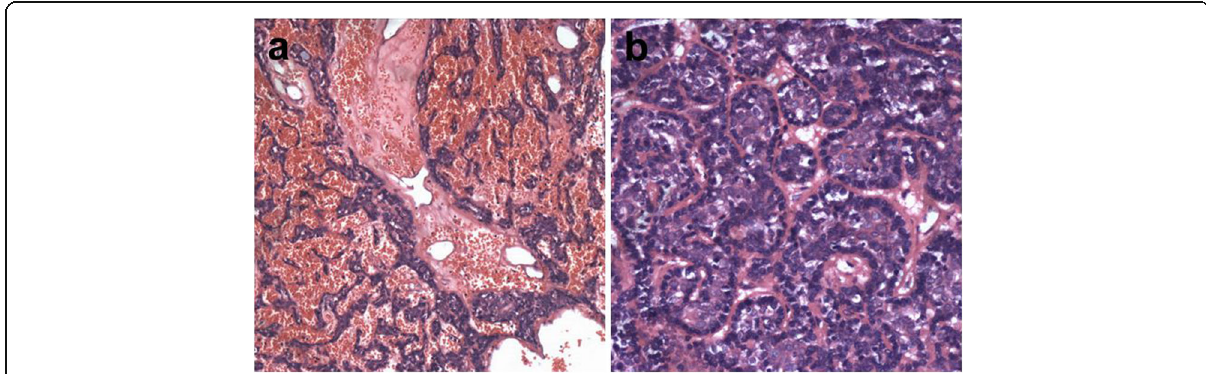
Fig. 2 Pathologic findings (hematoxylin and eosin staining) a The tumor consisted of three types of cell: large pale cells situated in the center, small basaloid cells located at the periphery and scattered spindle myoepithelial cells (× 200). b The stroma showed numerous dilated vascular spaces containing red blood cells and extensive hemorrhage (×